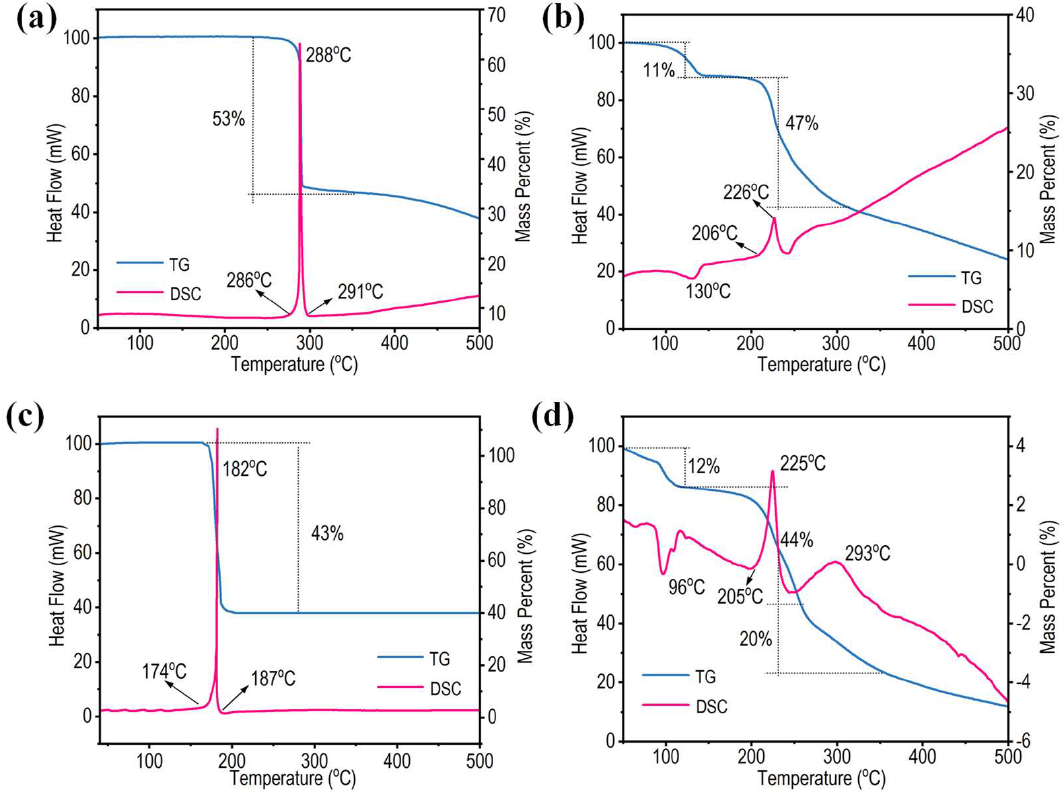
Figure 7. DSC and TG curves of DAPO ( a ), DAPOC·H 2 O ( b ), DAPOP ( c ), and DAPOT·3H 2 O ( d ).